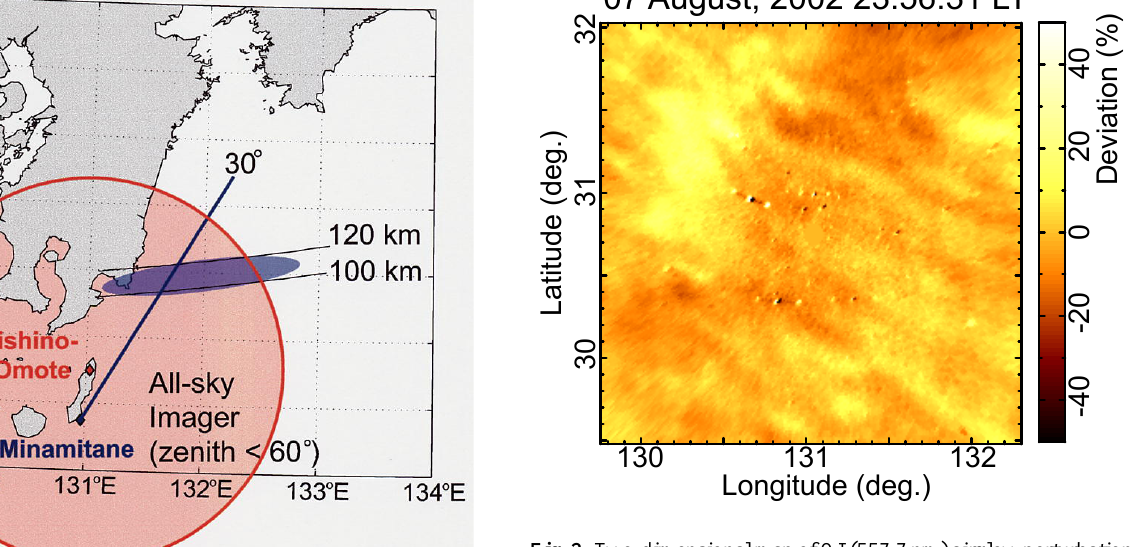
Fig. 2. Two-dimensional map of OI (557.7nm) airglow perturbation in the geographical